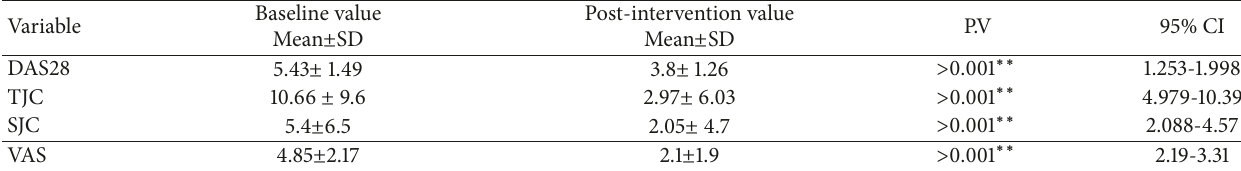
Table 1: Comparison between the mean of pre- and post-intervention values of clinical scores.